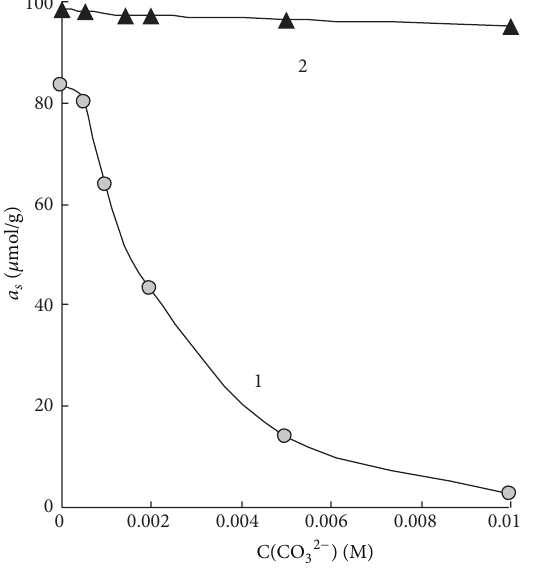
Figure 4: Comparative estimation of the recovery efficiencies of U(VI) from waste water with different forms of Zn,Al-L adsorbents.